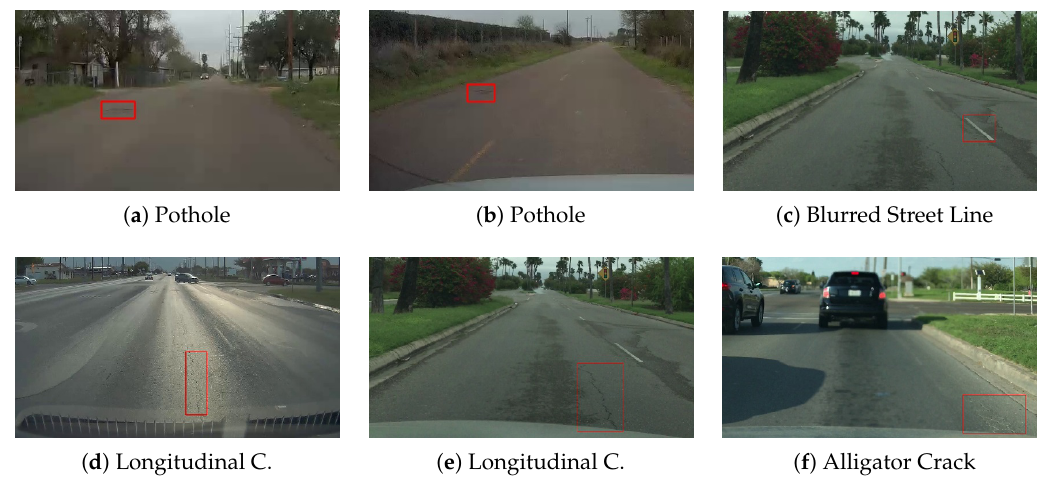
Figure 7. Examples of difficult false negatives, images that the detector was not able to